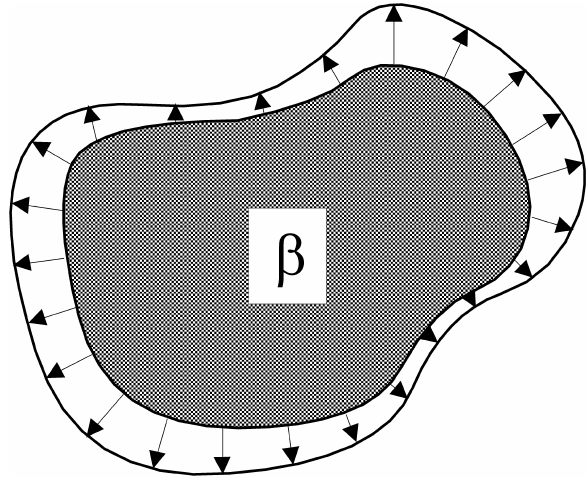
Figure 9. The distribution of velocities over the interface that bounds a feature illustrated in this figure is related to the changes in the geometric properties of the feature through the kinematic